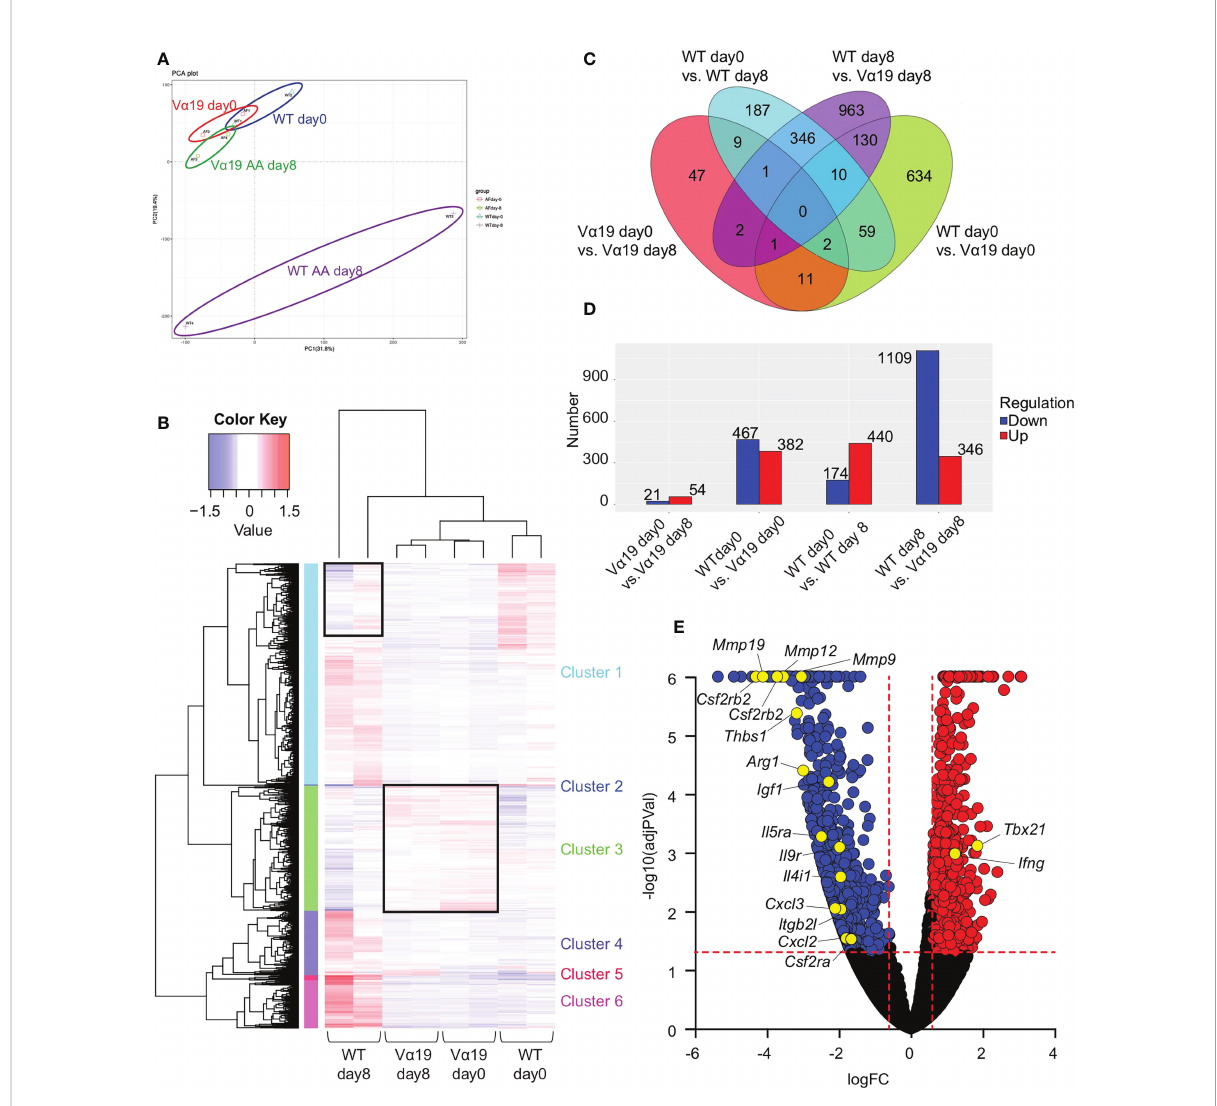
FIGURE 2 Transcriptome analysis of MAIT cells (A) Principal component analysis (PCA) Transcriptional data on MAIT cells from naïve wild-type mouse and V a 19 mouse lungs before the challenge (WT day 0 and V a 19 day 0), and those after the A alternata. challenge for 8 days (WT AA day 8 and V a 19 AA day 8) are plotted (n=2 per group). (B) Heatmap analysis Heatmap analyses of transcripts from A alternata- challenged wild-type and V a 19 mouse lung-derived MAIT cells (WT day 8 and V a 19 day 8, respectively), and naïve V a 19 and wild-type mouse lung-derived MAIT cells (V a